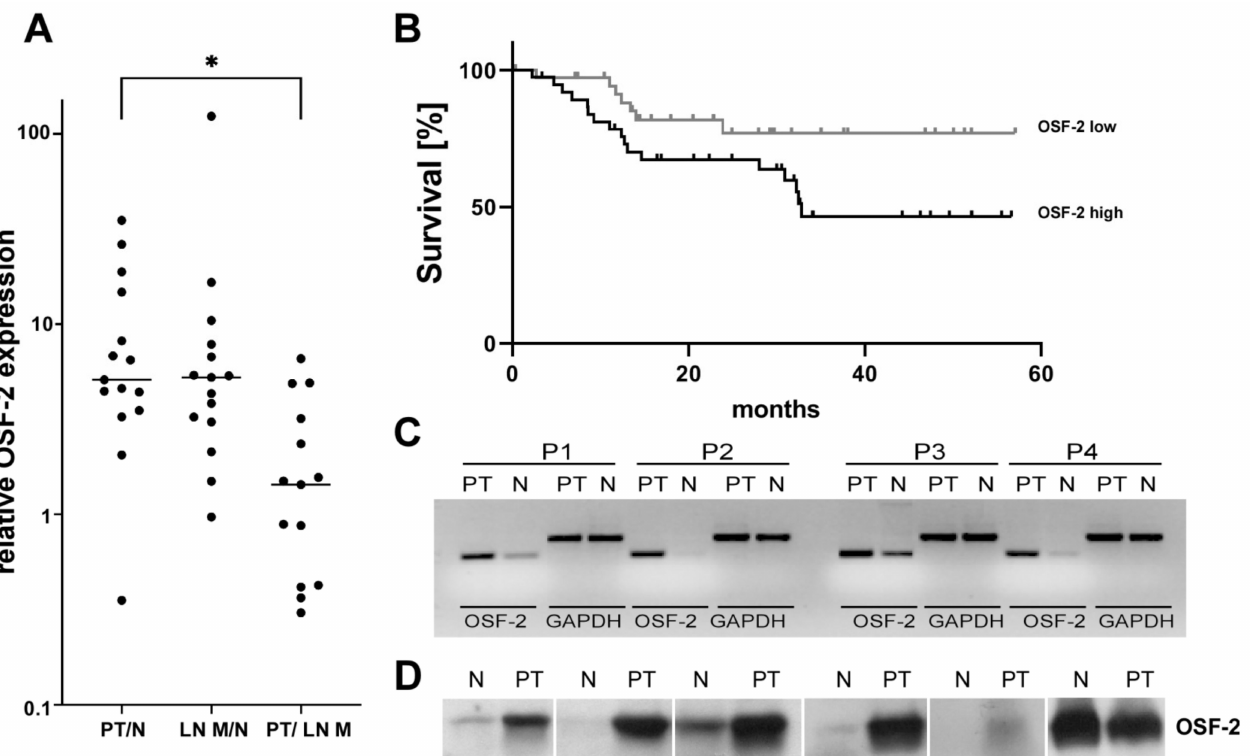
Figure 1. OSF-2 is significantly overexpressed in primary and metastatic HNCs. ( A ) RNA microarray analyses revealed at least 5-fold median overexpression of OSF-2 in the primary tumor (PT) versus normal tissue (N), as well as in lymph node metastases (LN M) versus N. PT versus LN M ratio indicated no further increase in OSF-2 expression in LN M (left). n = 15, * p < 0.05. ( B ) Survival analysis demonstrates that high OSF-2 expression levels correlate with reduced overall survival of HPV negative HNC patients; n = 75; p < 0.05. Hazard Ratio (Mantel-Haenszel) = 2.230. OSF-2 low < 12.3 (median), and OSF-2 high ≥ 12.3. ( C ) OSF-2 overexpression in PT versus N was confirmed by RT-PCR. OSF-2 up-regulation is shown in four representative cases (demographics see Table S1). GAPDH was used as a control. ( D ) Verification of OSF-2 microarray results on the protein level ( n = 6). Higher expression of OSF-2 protein was found in PT versus N in five out of six representative cases. The uncropped western blot figures were presented in Figure